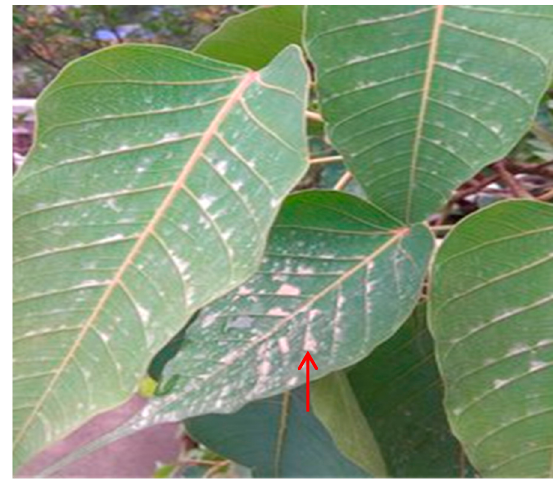
Figure 1. Red arrow indicates deposited dust on leaves [23].